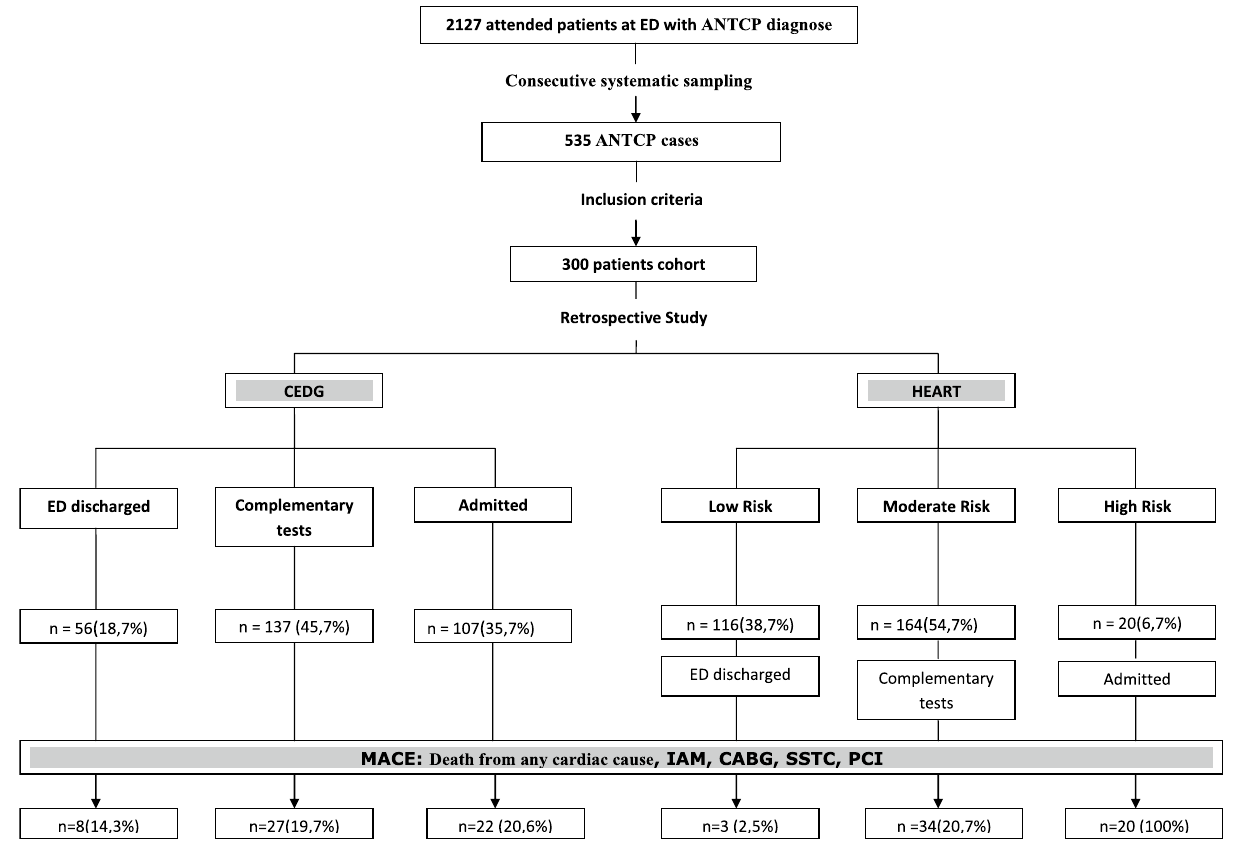
Figure 1. Patient flow chart for patients included in current comparison of performance of the HEART score and ‘Current Emergency Department Guidelines’